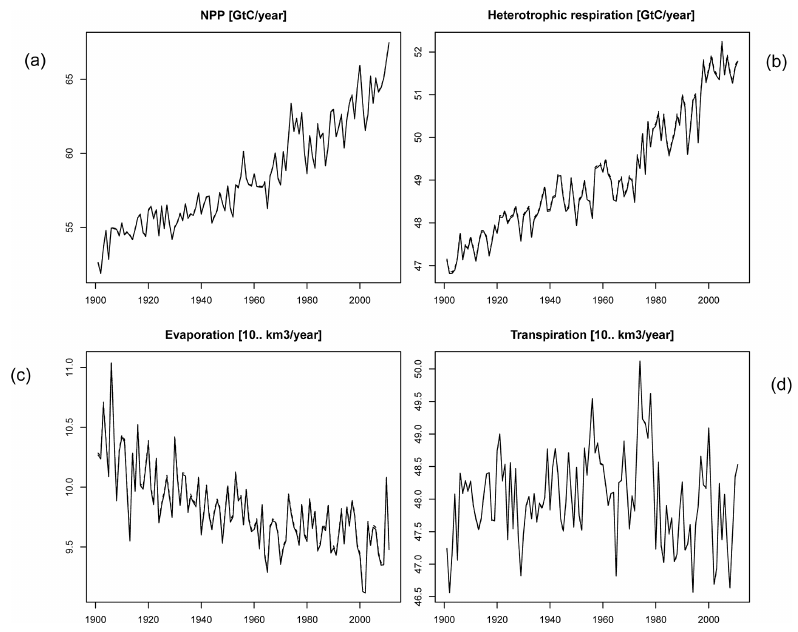
Figure C2. Global number for time series of (a) NPP, (b) heterotrophic respiration, (c) evaporation, and (d) transpiration.